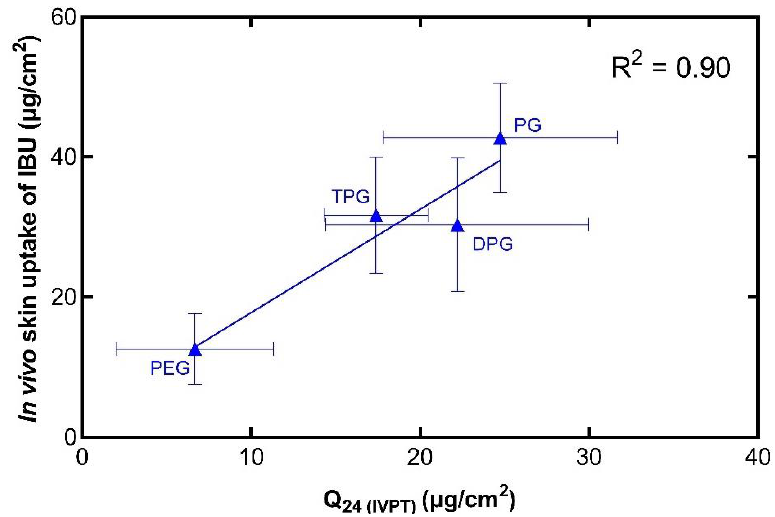
Figure 9. Correlation of the in vitro cumulative amount of IBU permeated after 24 h (mean ± SD, n = 5) and the total amount of IBU in the SC per skin surface area in vivo (mean ± SD, 4 ≤ n ≤ 5).